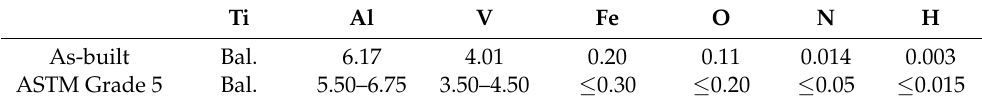
Table 2. Chemical composition of the as-built specimen used in this study (mass%). Ti